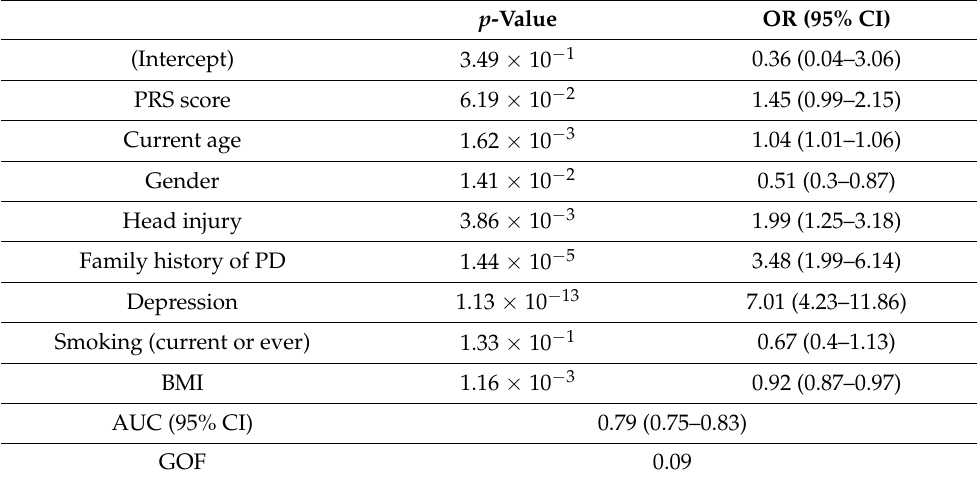
Table 6. Stepwise-regression analysis by forward selection, backward elimination, and bidirectional elimination approaches using data before imputation.